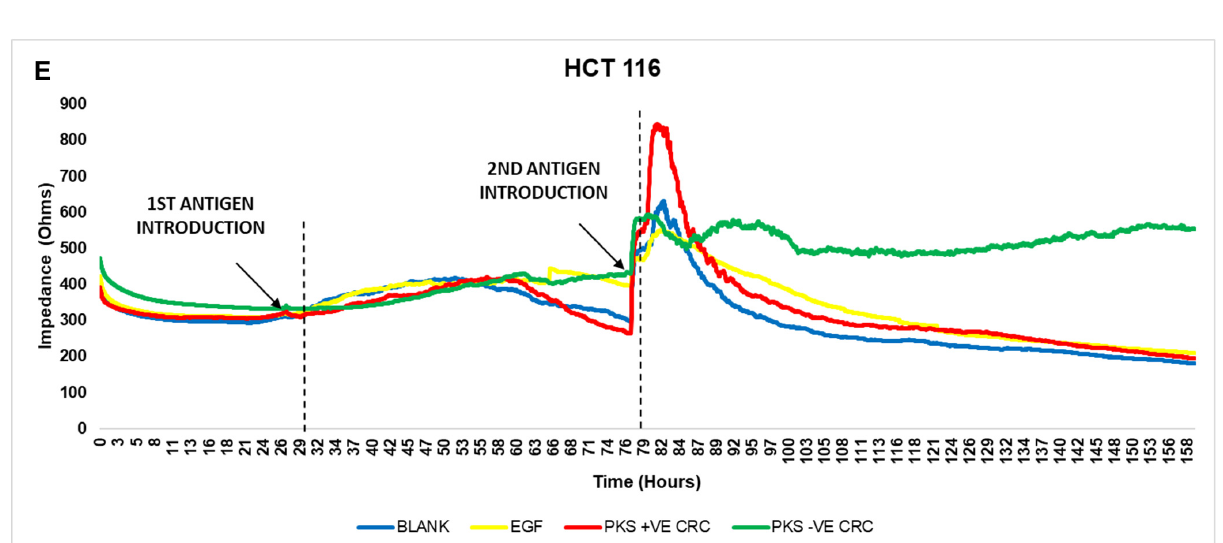
Figure 10. Impedance of CRC cell lines upon recurrent exposure to K. pneumoniae antigens. ( A ): Figure 10: Impedance of CRC Cell Lines upon recurrent exposure to K. pneumoniae antigens. healthy, ( B ): stage I, ( C ): stage II, ( D ): stage III, ( E ): stage A: Healthy, B: Stage I, C: Stage II, D: Stage III, E: Stage IV.